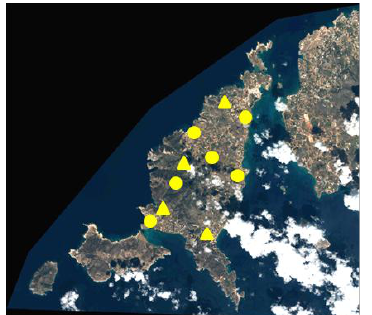
Figure 4. GeoEye-1